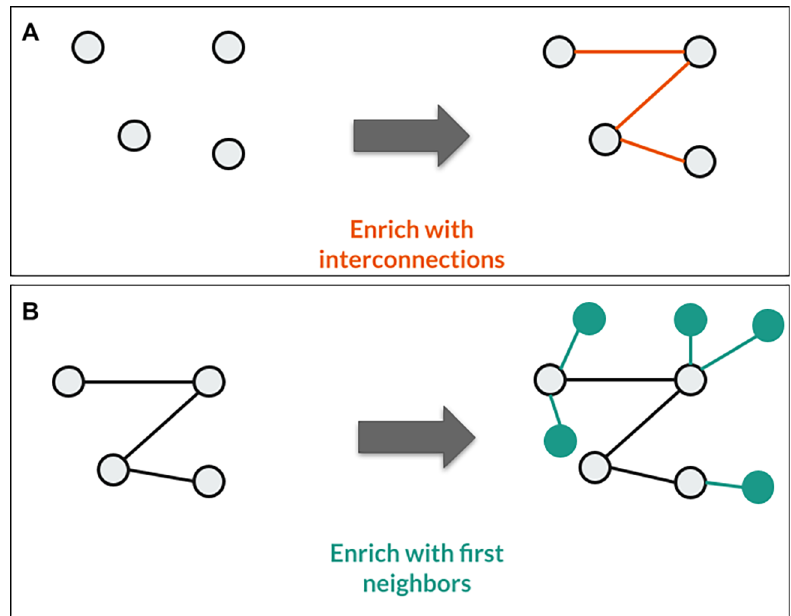
Figure9.Representationofthethirdusecase. A:WiththegivenSQLquery,Sherlockcanfindtheinterconnections between the selected proteins in this step. B: After a single logical operator change between the two queries (AND operator to the OR operator), Sherlock can also identify the selected proteins' first